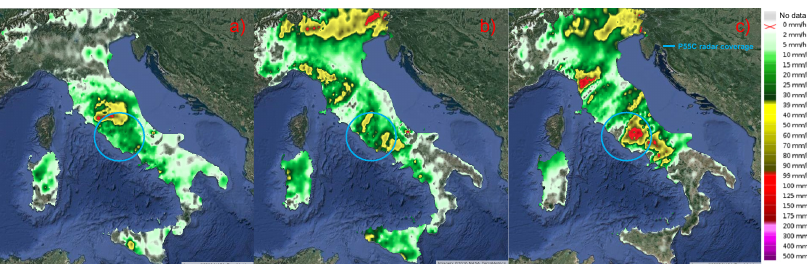
Figure 1. From left to right: 24 h rain accumulations for the case of studies on 12 October 2012, 15 October 2012 and 14 October 2015 registered by the Italian rain gauge network. See main text for details.